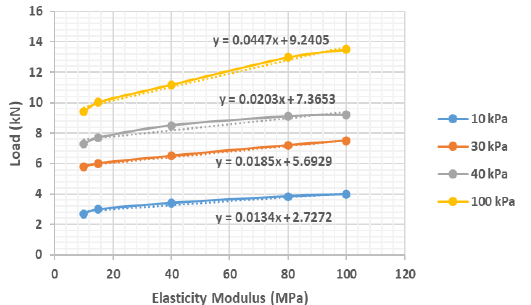
Table 9. Pile foundation capacity in relation to Young’s modulus of soil for CHSB 1 pile. Figure 7. Elasticity modulus versus ultimate load for CHSB 1 Figure 7. Elasticity modulus versus ultimate load for CHSB 1 pile.